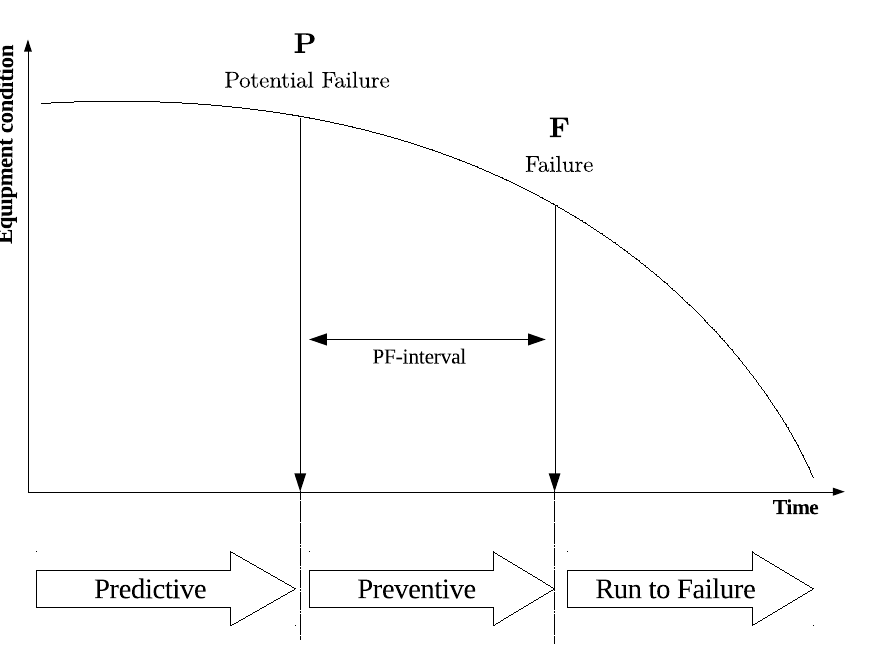
Figure 1. P-F reliability curve in maintenance management [8].